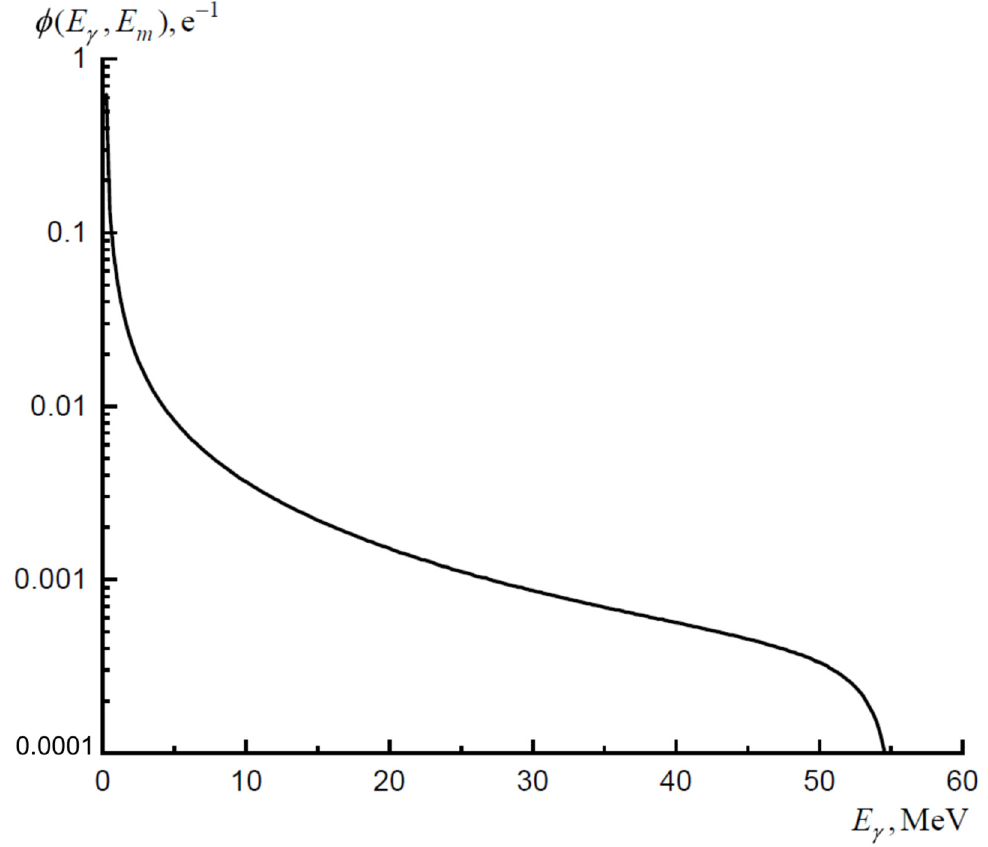
Figure 5. Bremsstrahlung spectrum per one beam electron for used convertors. Table 2. Isotope composition of 60 Ni foil according to manufacturer’s data. Isotope Content,